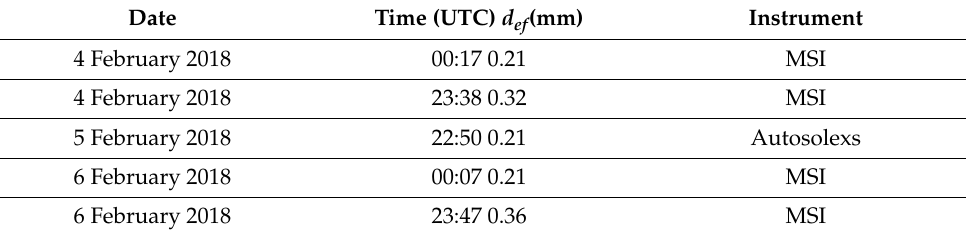
Table 4. The time of satellite/ground albedo retrievals/measurements over Dome C (Antarc- tica) shown in Figures 3 and 4. Further details on the ground measurements are given in [7]. The satellite SZA was in the range 65–67 degrees and ground measurements were performed at SZA = 71.6 degrees. The vale of d ef for the case of ground Autosolex measurements have been retrieved using the same approach as dicussed above for spacebrone